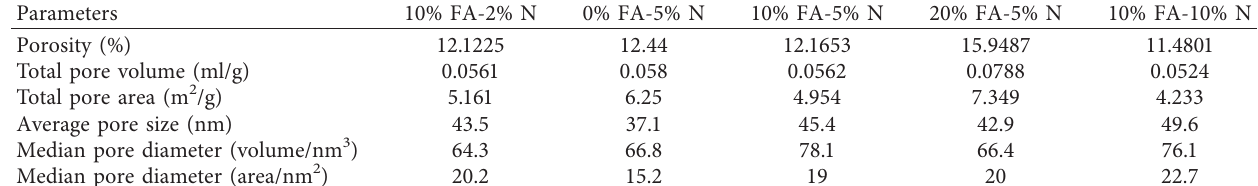
Table 7: Pore characteristics of concrete under different conditions after 150 coupling